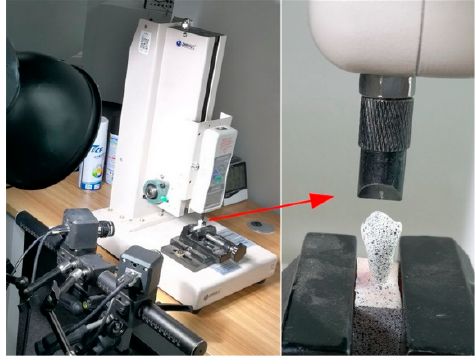
Figure 2. Measurement setup. The 3D DIC device monitoring the buccal surface of the specimen that fixed on the fixture of the testing machine.